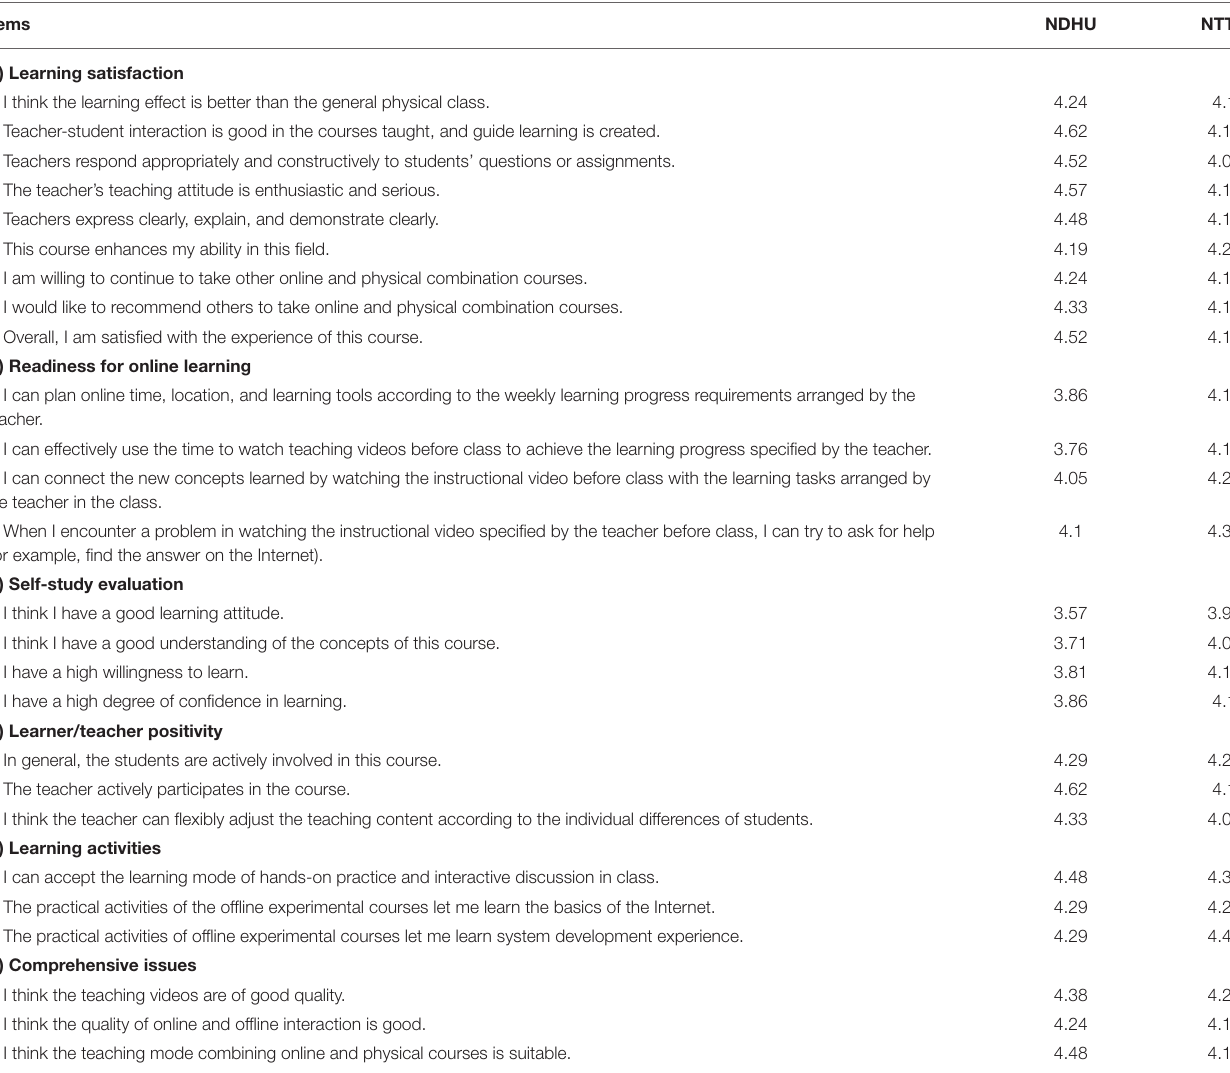
TABLE 1 | Average of curriculum learning experience questionnaire survey.